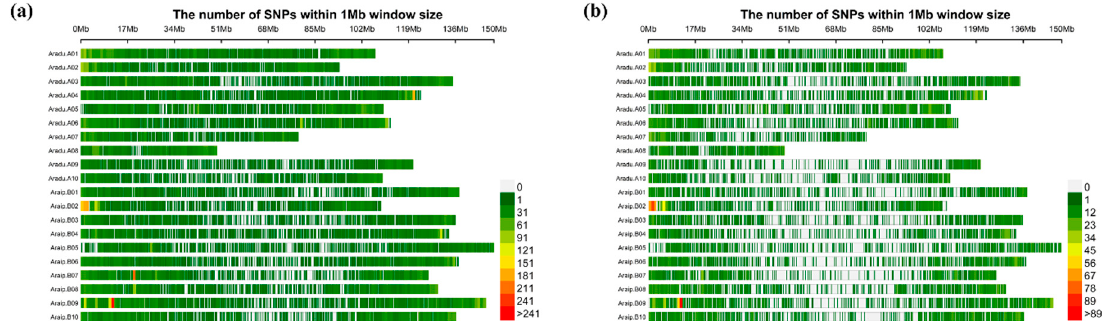
Figure 1. Single nucleotide polymorphisms (SNP) distribution in the 20 chromosomes of the cultivated peanut. The horizontal axis shows chromosome length (Mb), the shades of red represent SNP density. The vertical axis shows the 20 chromosomes. ( a ) Polymorphic SNPs except for scaffold markers; ( b ) Polymorphic SNPs (except for scaffold markers) after filter by GAPIT